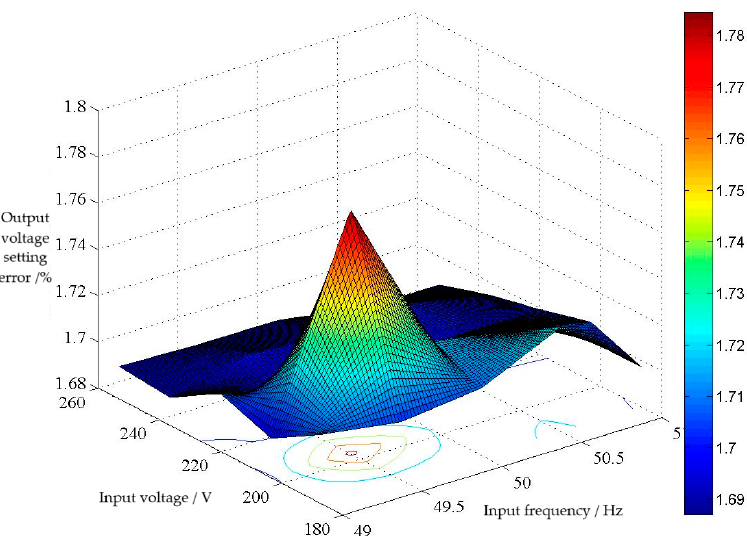
Figure 2. Output voltage setting error test result diagram.